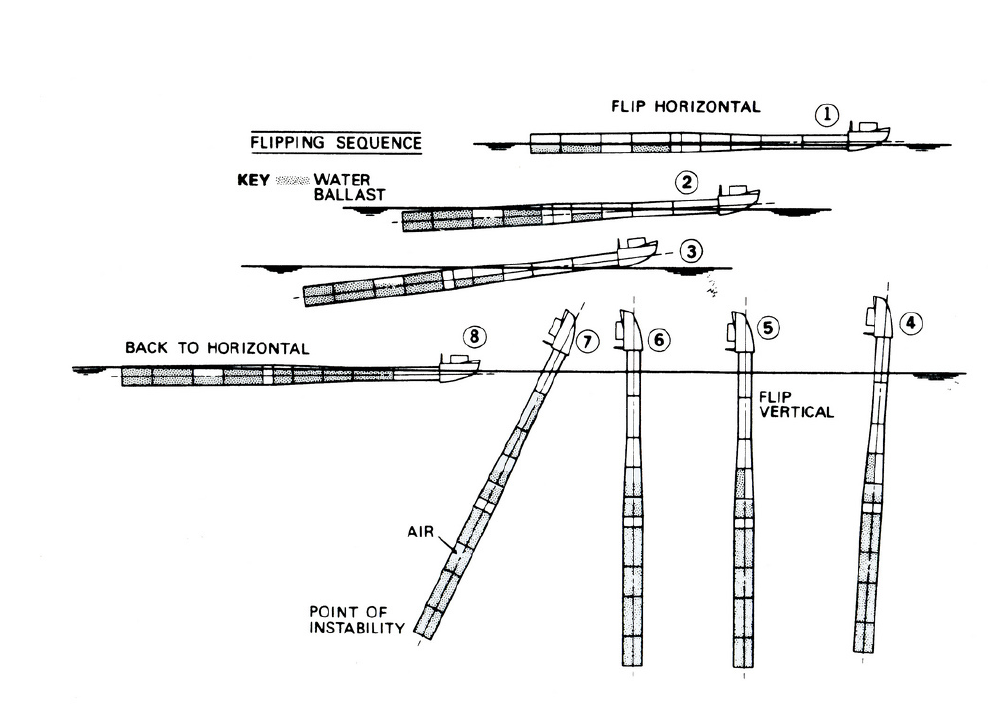
Figure 2: FLIP ’s flipping sequence. From Bronson and Glosten 1985, 17, adapted from Fisher and Spiess 1963. Courtesy of Scripps Institution of Oceanography at UC San